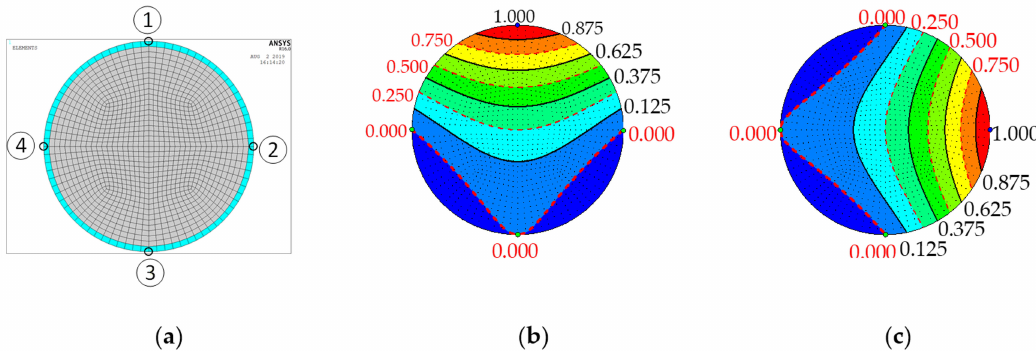
Figure 1. Finite element model and contour maps of numerical shape functions: ( a ) The square plate model; ( b ) shape function N 1 ; ( c ) shape function N 2